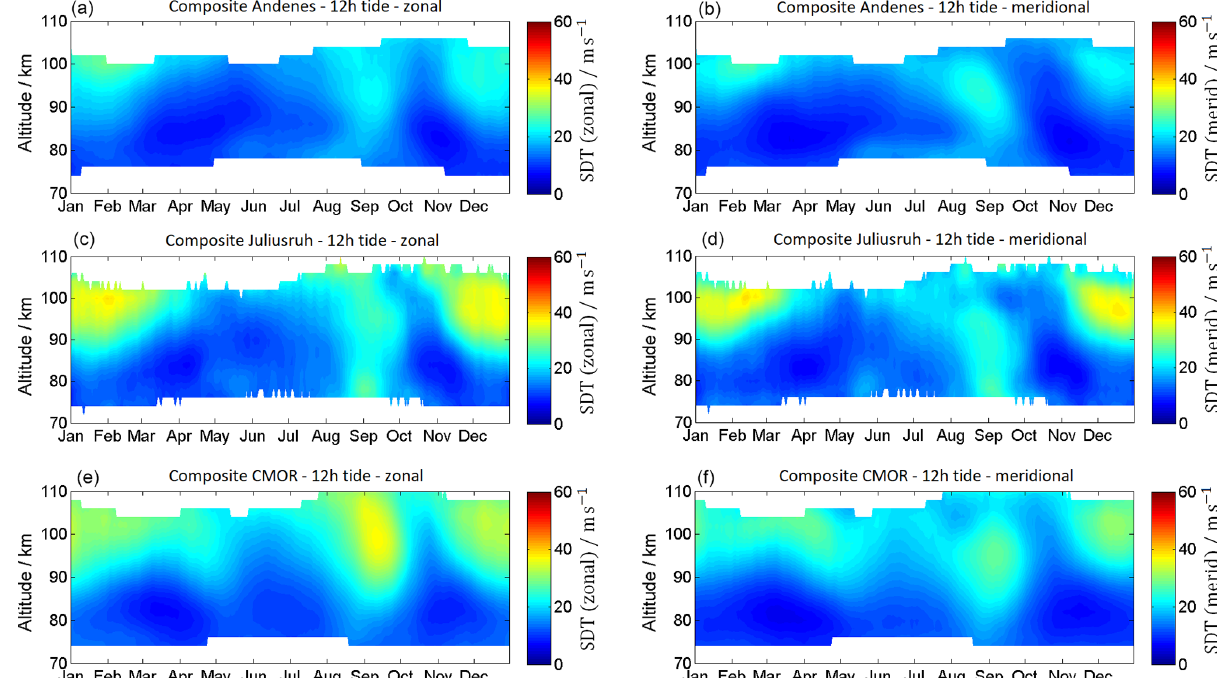
Figure 12. Same as Fig. 8 but for the semidiurnal tidal